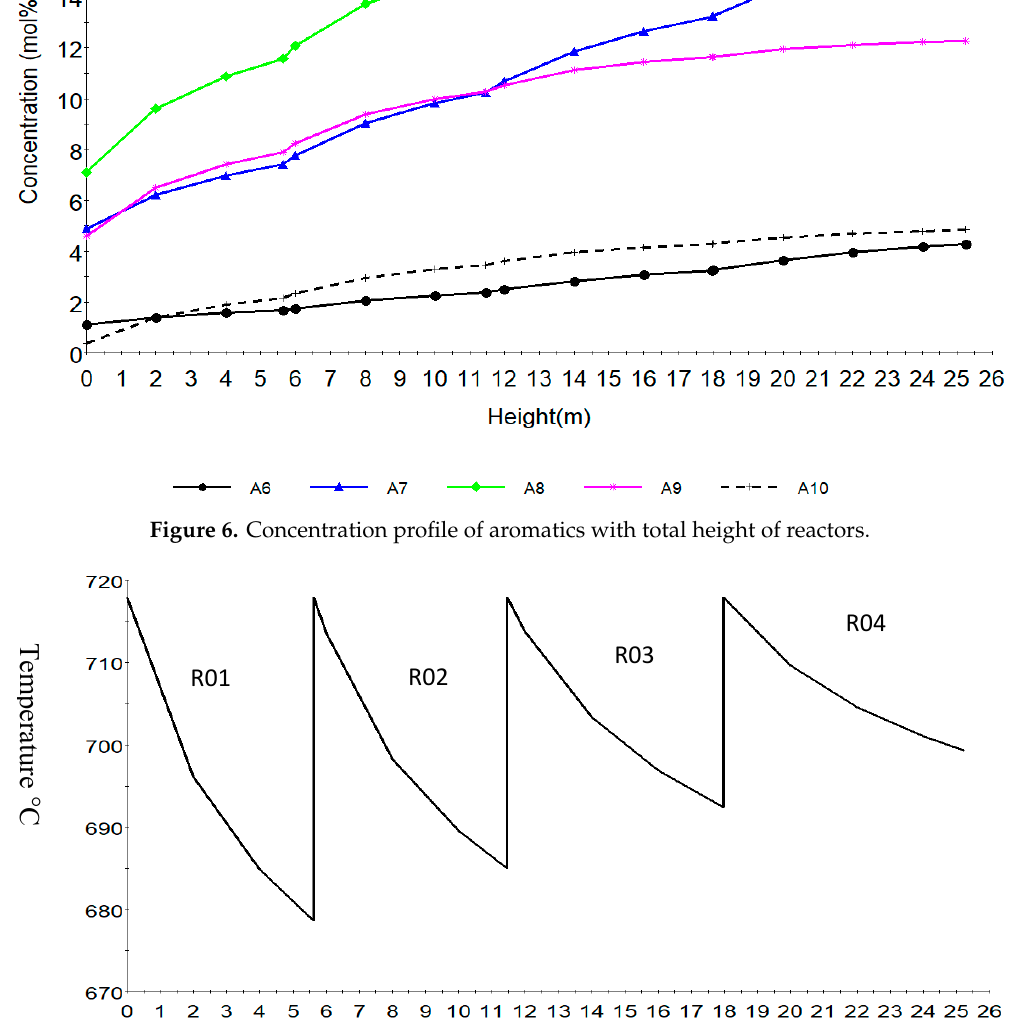
Figure 7. Temperature profile in the four reactors.